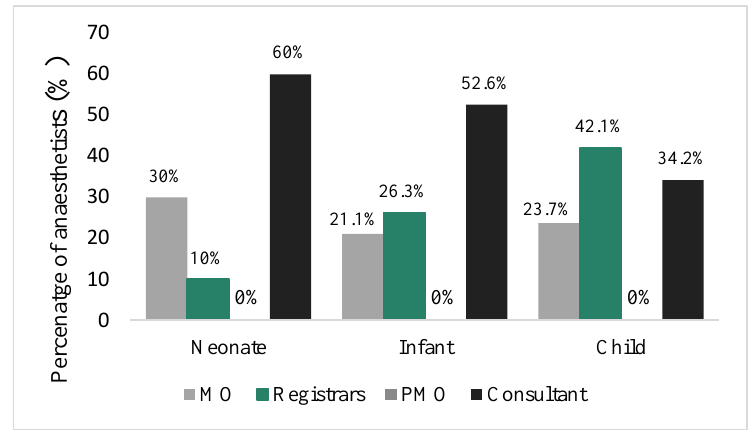
Figure 5. Use of suxamethonium during RSI by grade of anaesthetist.